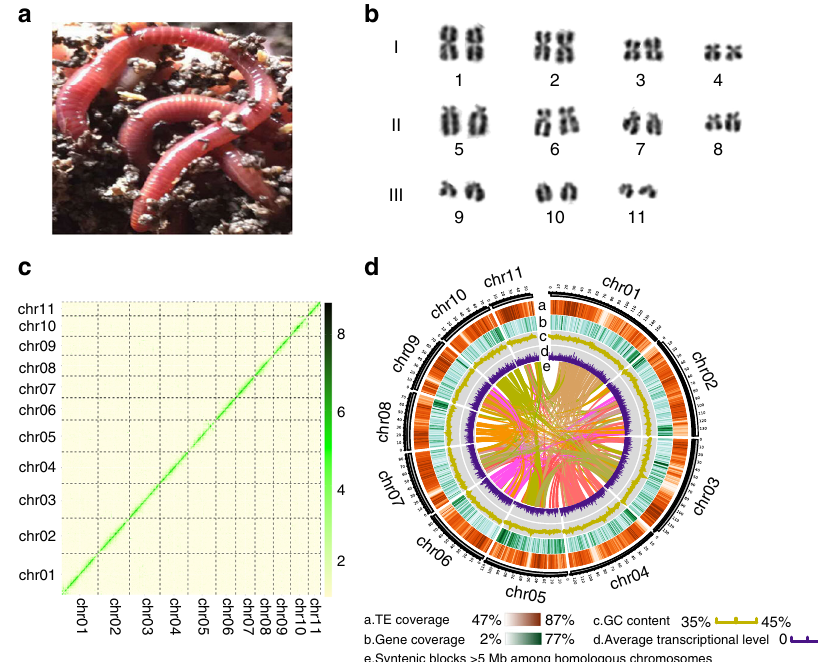
Fig. 1 Genome assembly of the earthworm. a A earthworm strain ( E. andrei ) sequenced by the PacBio platform. b Karyotype of the earthworm. 2 n = 22. Chromosomes were classed into three subtypes according to their morphological differences. The karyotype was obtained from metaphase cells in the earthworm clitellum. These analyses were performed by Conservation Genetics CAS Kunming Cell Bank. c Hi – C interactions among 11 chromosomes. Strong interactions were indicated in dark green and weak interactions were indicated in light green. d Circos diagram depicting the characteristics of the earthworm genome. The tracks from outer to inner circles indicated the following: chromosomes, TE coverage, gene coverage, GC contents, gene expression and syntenic block >5 Mb among homologous chromosomes,